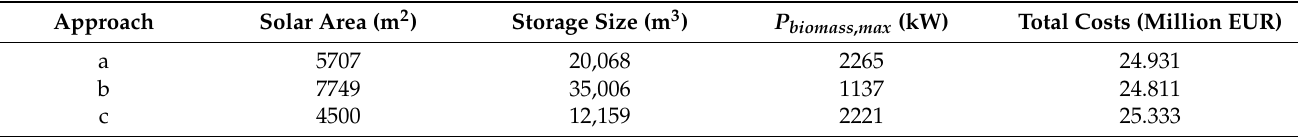
Table 1. Optimal configuration for each approach for step 3.